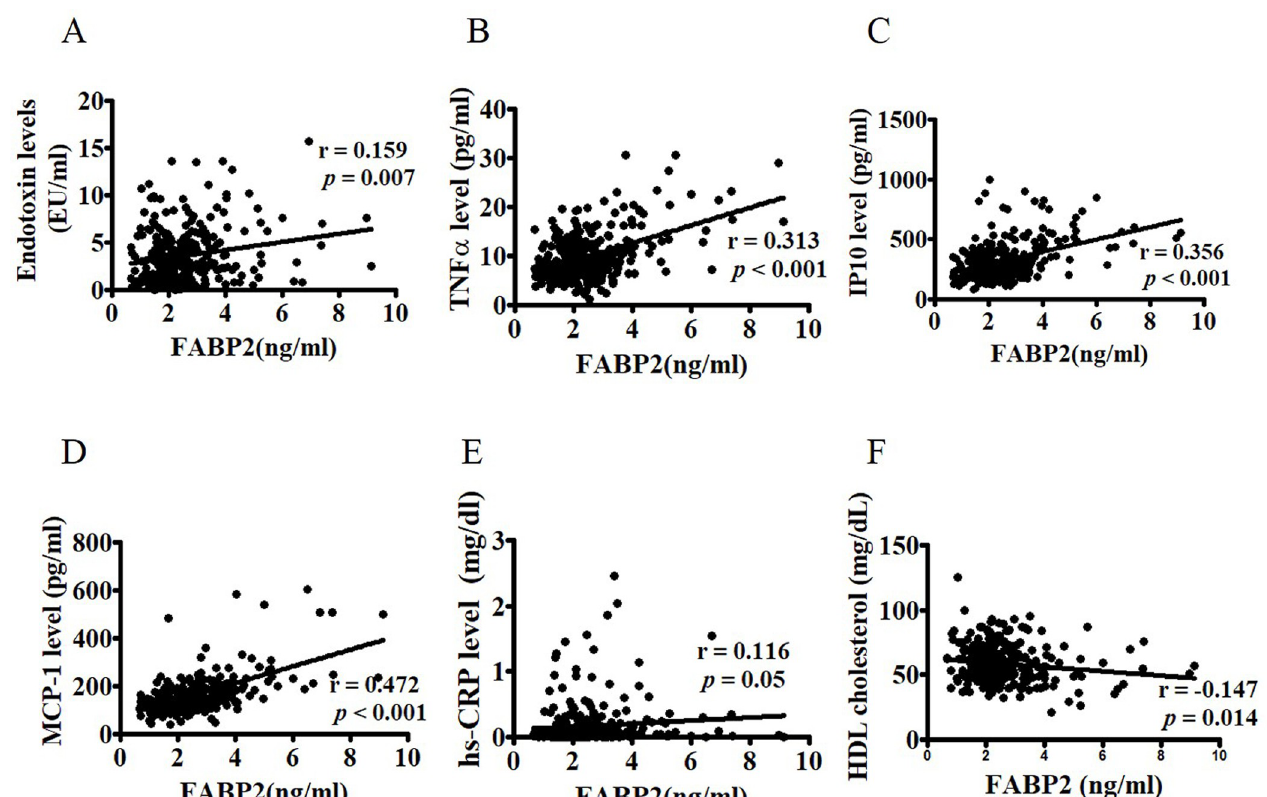
Fig 1. Correlation between FABP2 and circulating inflammatory factors. Correlations between FABP2 levels and endotoxin (A), TN-F α (B), IP10 (C), and MCP-1 (D) as well as hs-CRP € and HDL cholesterol (F) in 289 postmenopausal women were determined using Spearman’s correlation analysis. FABP2: fatty acid binding protein 2; TNF- α : tumor necrosis factor alpha; IP10: interferon-inducible protein-10; MCP-1: monocyte chemoattractant protein-1 high- sensitivity C-reactive protein; HDL: high-density